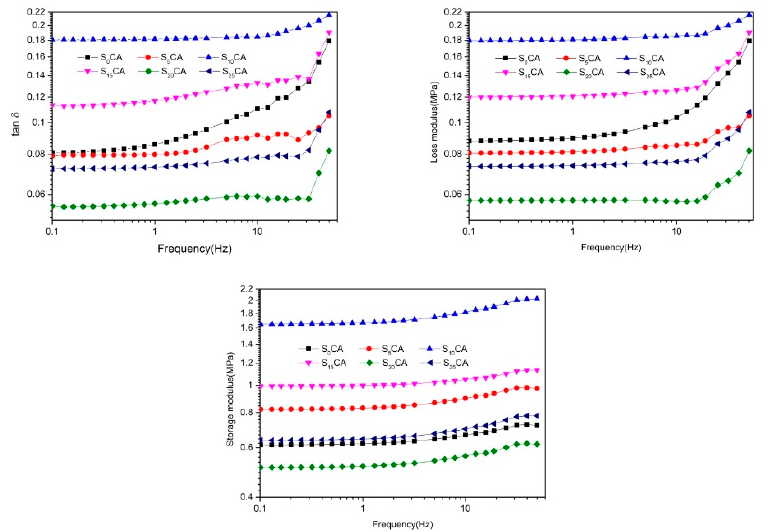
Figure 6. Storage modulus, loss modulus, and tan δ versus frequency curves of the aerogels with different starch content.